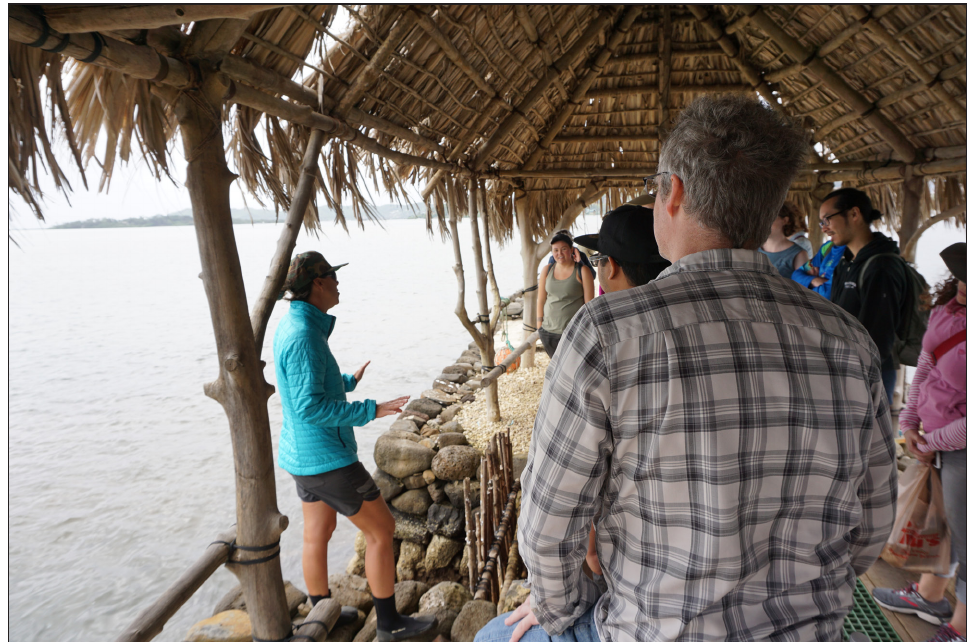
Figure 1: Workshop participants shared ideas and visited sites such as Paepae o He‘eia, a restoration project for a tradi- tional fishpond. Photo by Aya Hirata